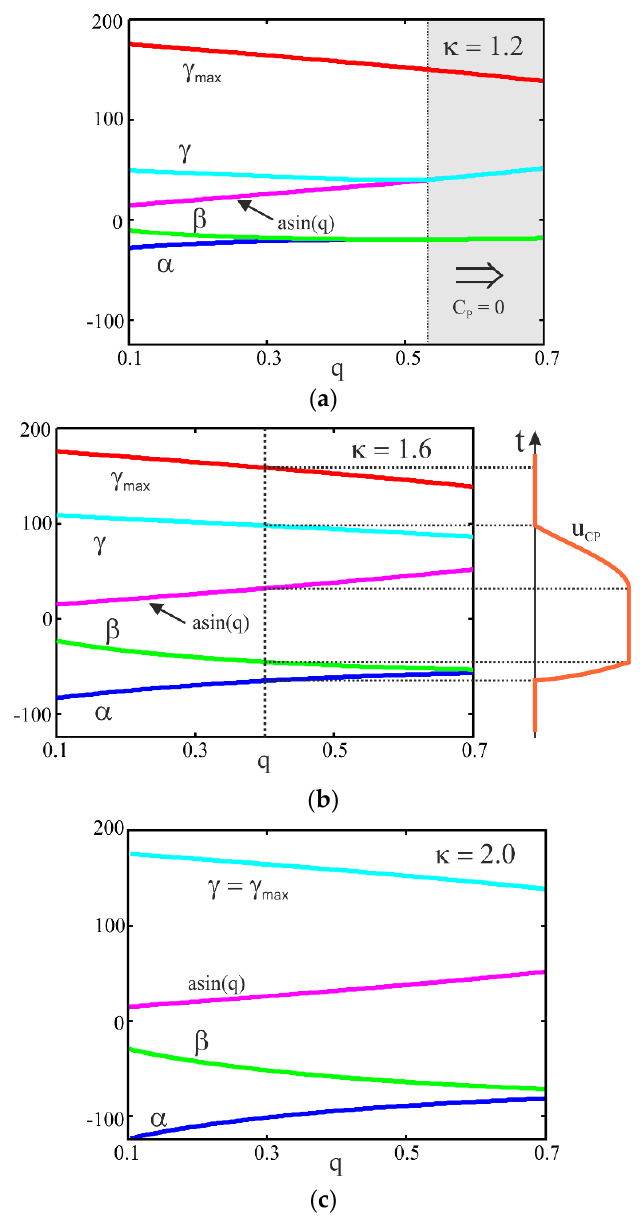
Figure 4. Variation of the angles α , β , asin(q) , γ and γ max in degrees as a function of q for different ĸ values: ( a ) ĸ equal to 1.2; ( b ) ĸ equal to 1.6; ( c ) ĸ equal to 2.0.